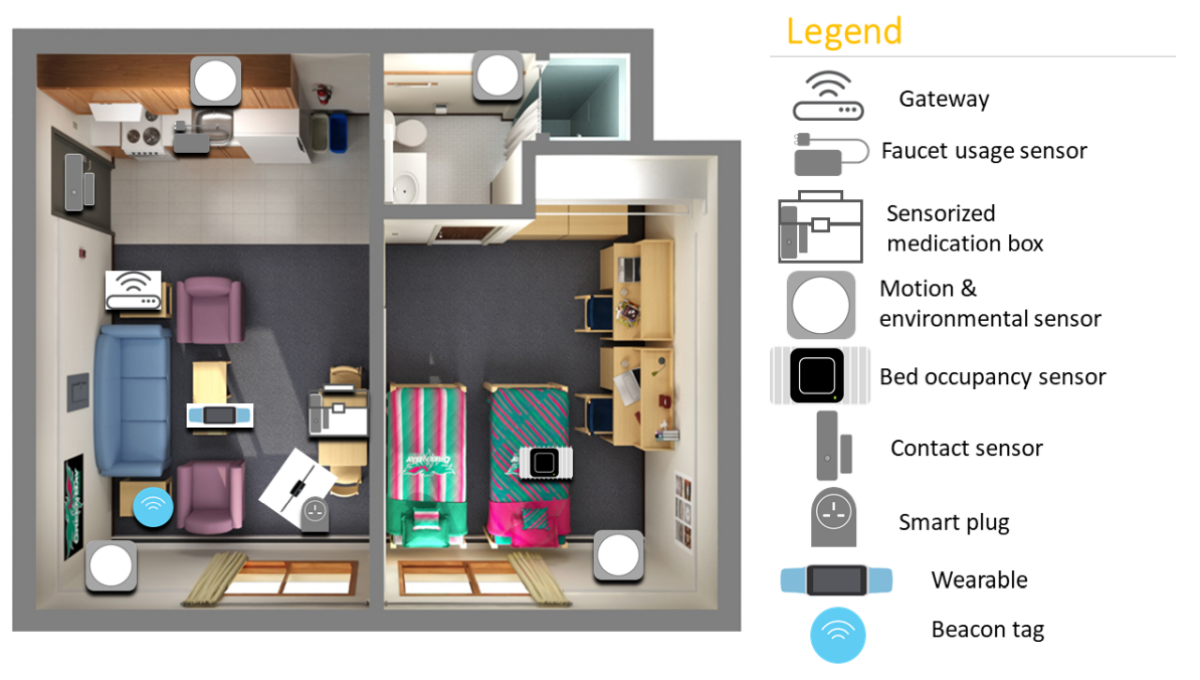
Figure 1. Multimodal sensor set up in homes.